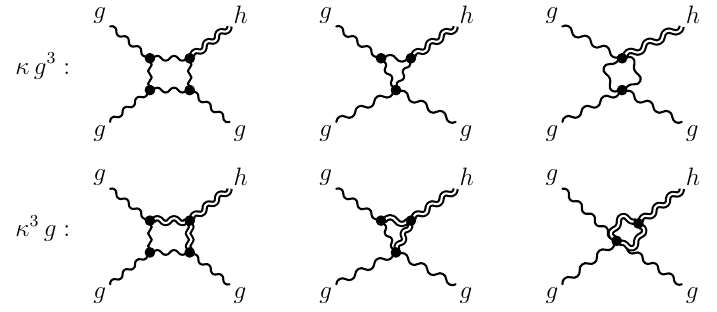
Figure 1 . Contributions to the one-loop EYM amplitude A 3+1 (1 ; 2 ; 3; h ) at di(cid:11)erent orders in (cid:20) and g . Only the top line of the O ( (cid:20) g 3 ) contribution of the amplitude is constructible by replacing the gluon by a (massive) scalar from (1.5) in the rational